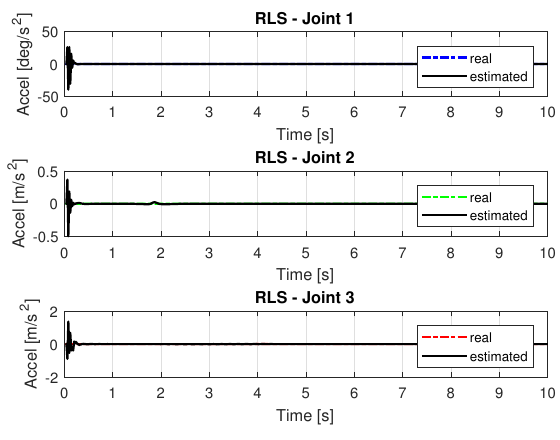
Figure 14. Accelerations of joints with RLS.